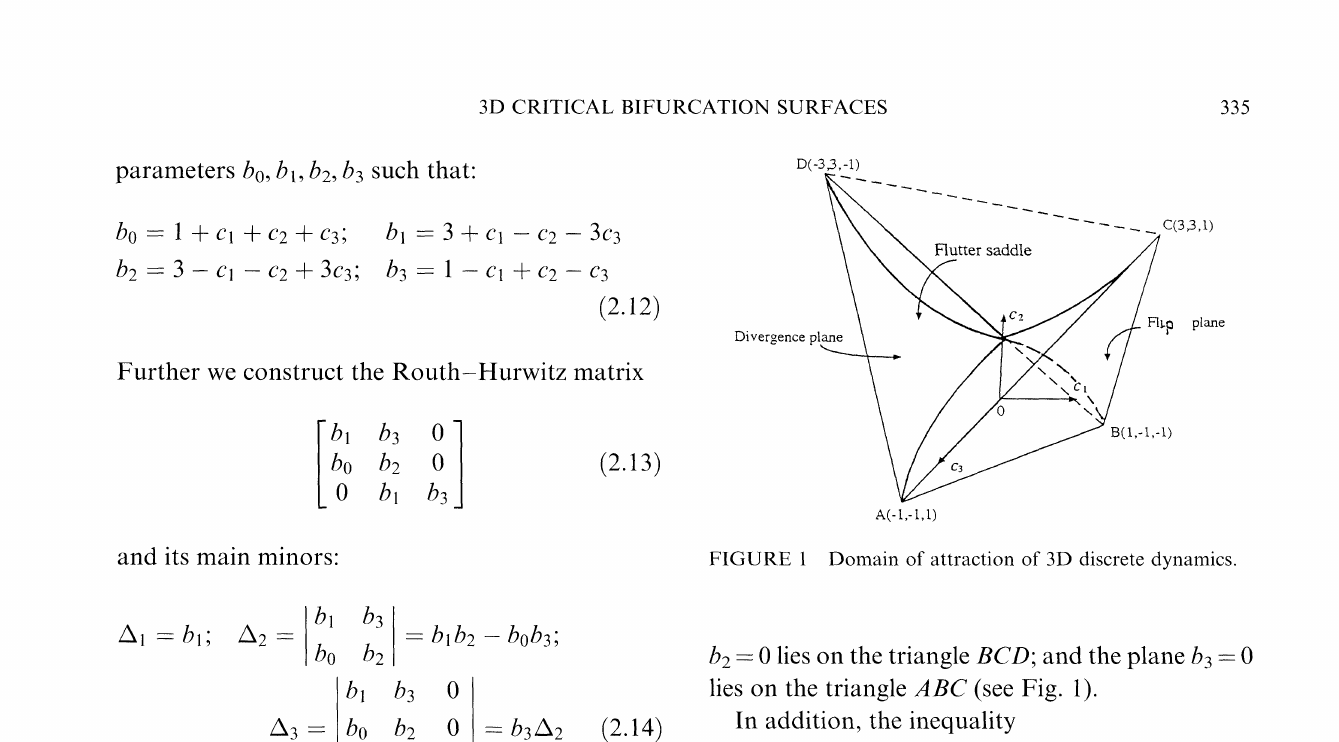
Domain of attraction of 3D discrete